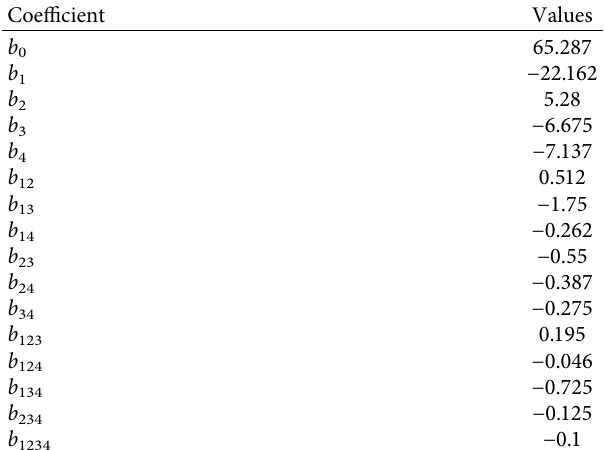
Table 9: Values of model coefficients of the